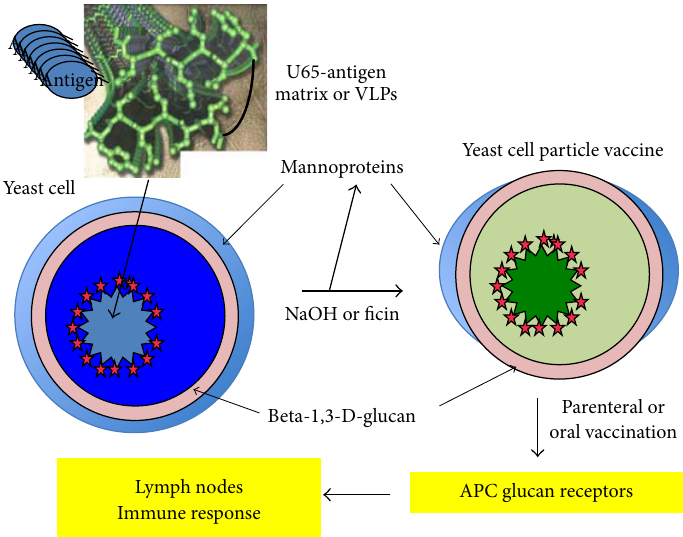
Figure 1: YCP vaccine processing and